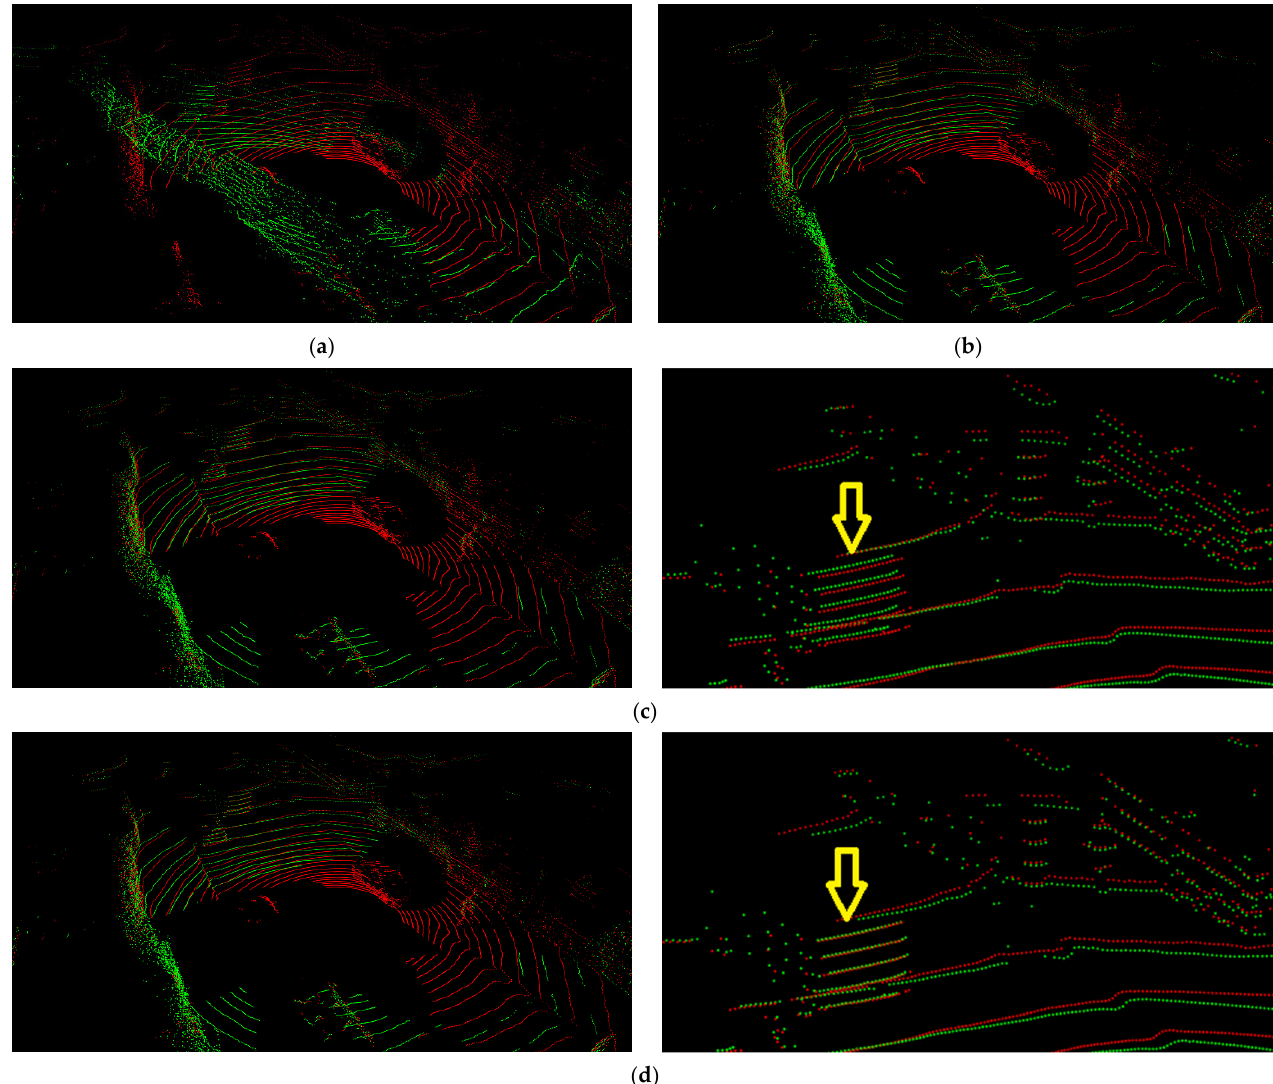
Figure 6. Results of applying the proposed method to a test frame of the Oxford dataset. ( a ) Trans- formation by randomly sampled deviations. ( b ) Transformation by given calibrated parameters. ( c ) Transformation by RT 1 inferred from Net1. ( d ) Transformation by RT online obtained from iterative refinement by five networks.